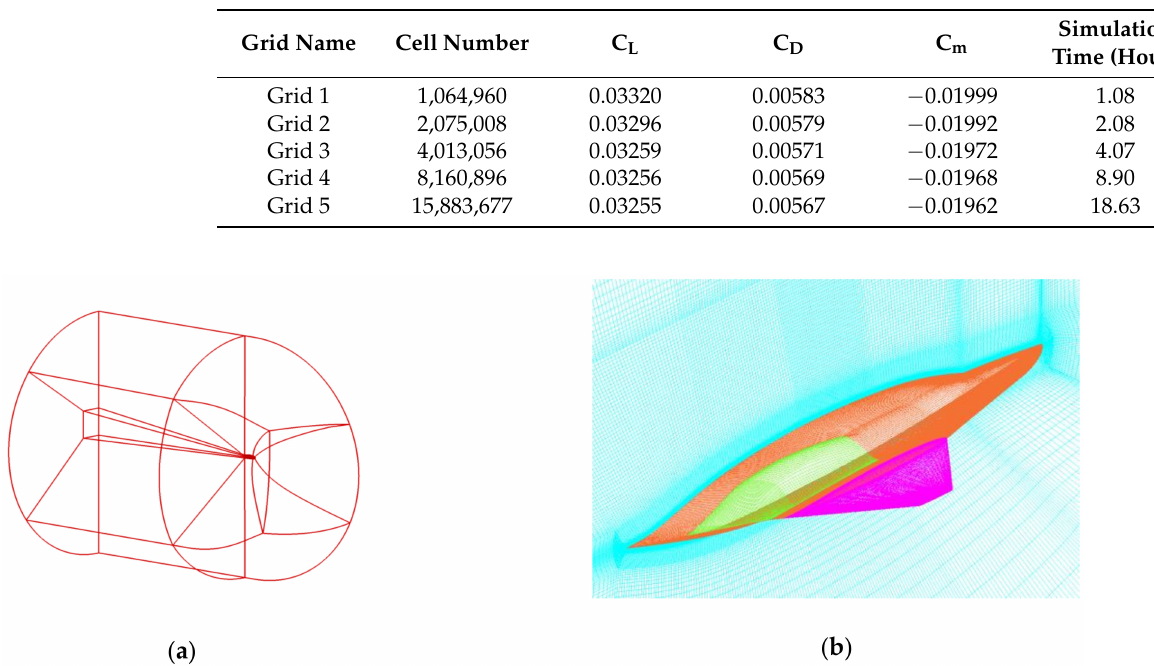
Figure 9. The grid of the model. ( a ) Grid topology. ( b ) Mesh around the model.